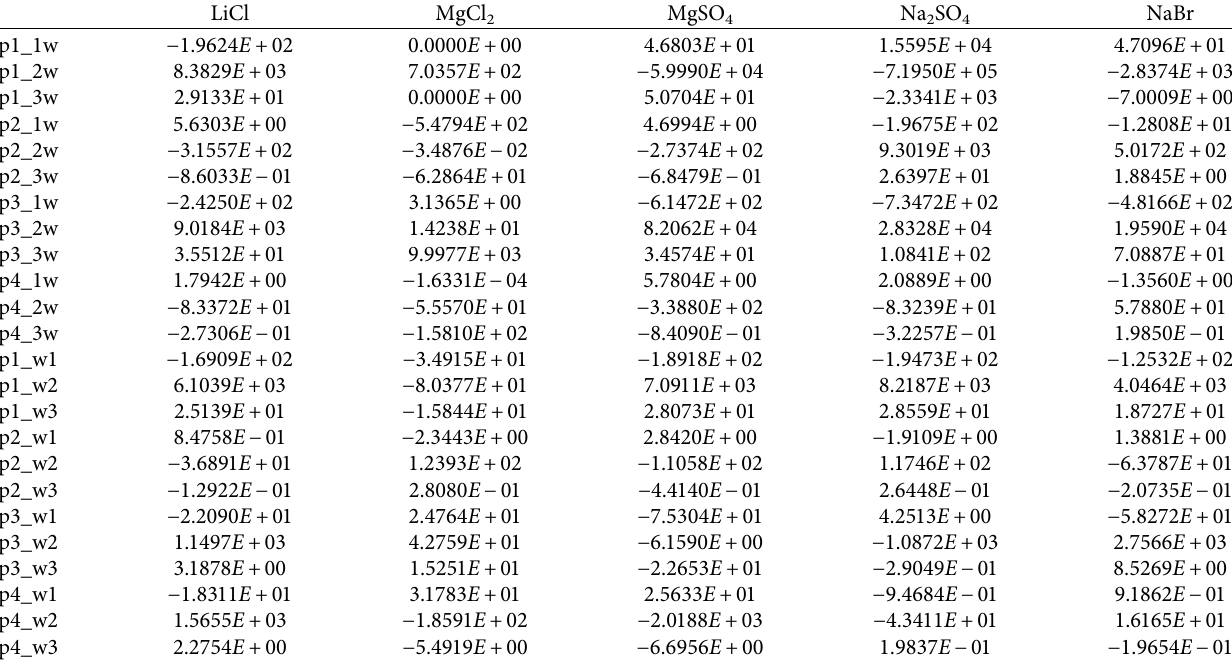
Table 3: Interaction parameters 3.